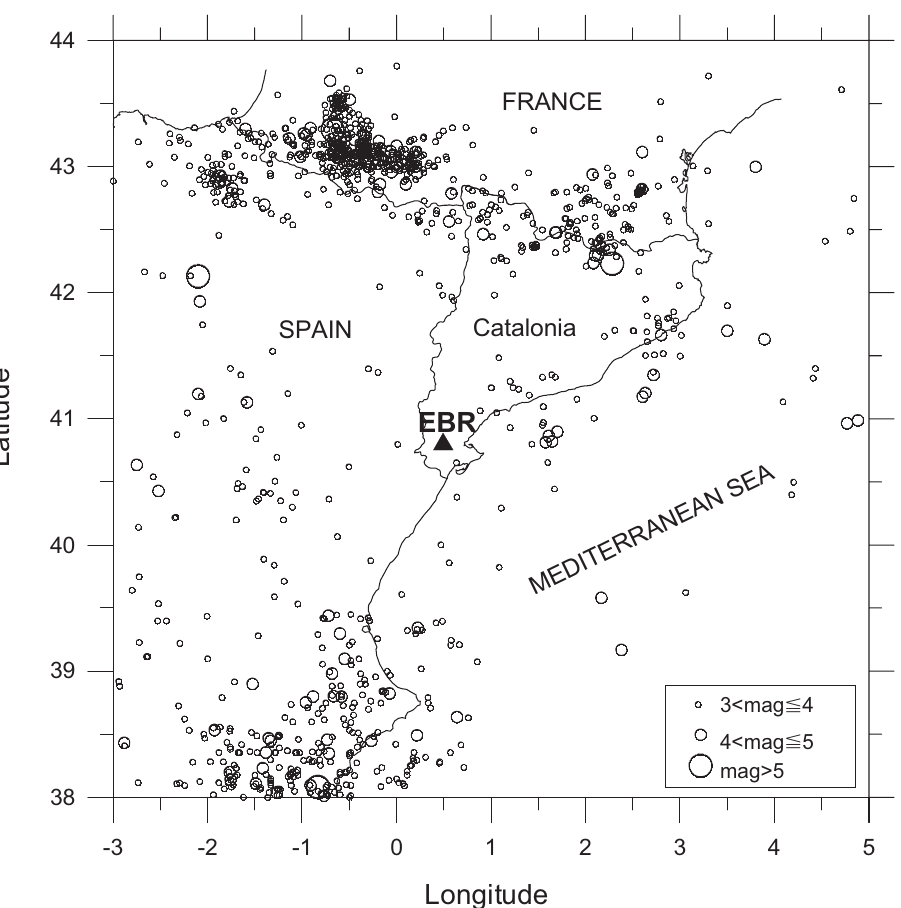
Fig. 1. Map showing the station location and surrounding seismicity. Earthquakes with magnitudes greater than 3 occurring up to February 2003, according to the seismic of the Istituto Geogra´fi co Nacional (Spain), are